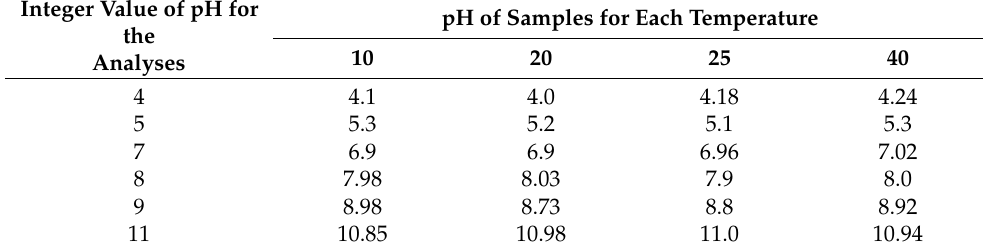
Table 2. pH measures according to